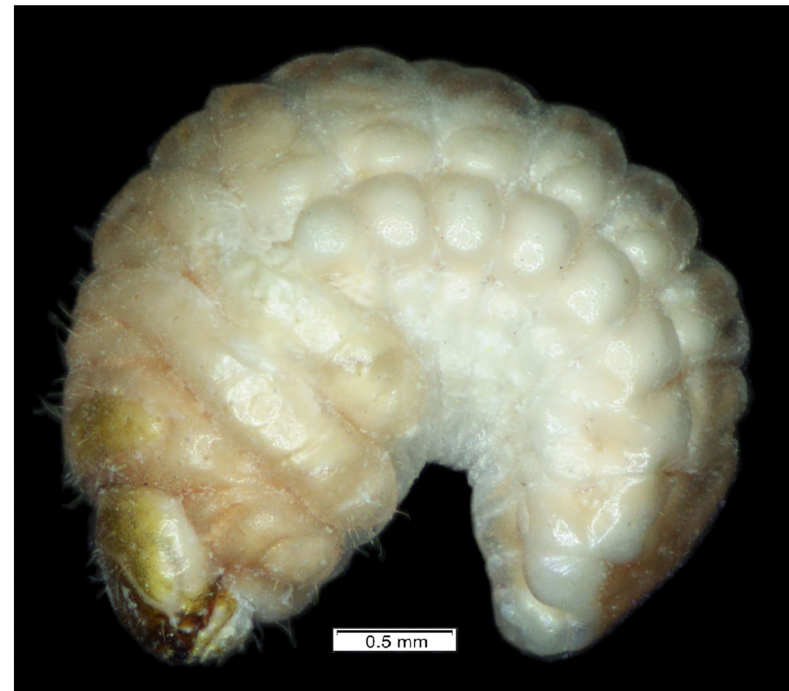
Figure 1. Lachnaeus crinitus habitus of mature larva, lateral